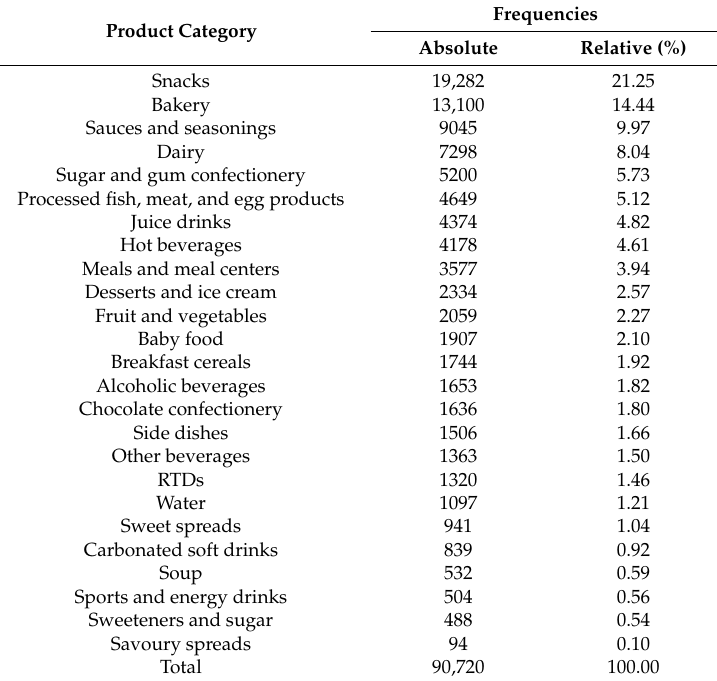
Table 1. Frequency distribution of launched products by category 1